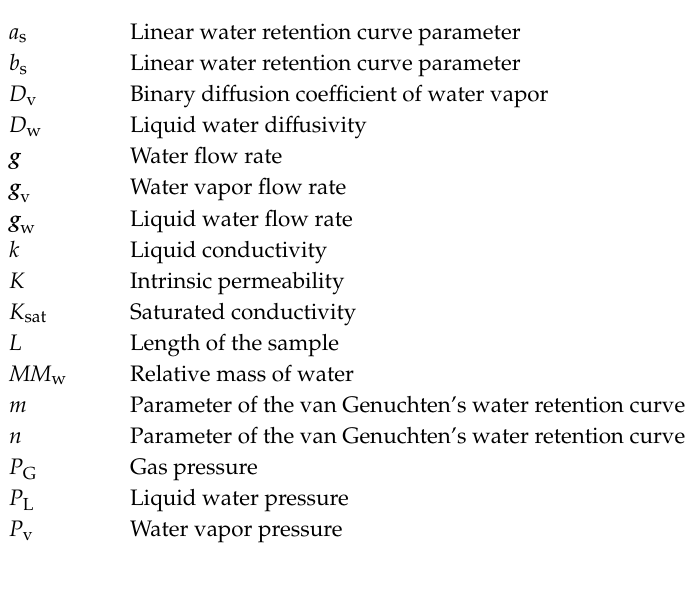
Figure S1: X-ray diffraction. (a) OPS and (b) SPS, Figure S2. MIP test. (a) OPS and (b) SPS, Table S1: Chemical composition of the